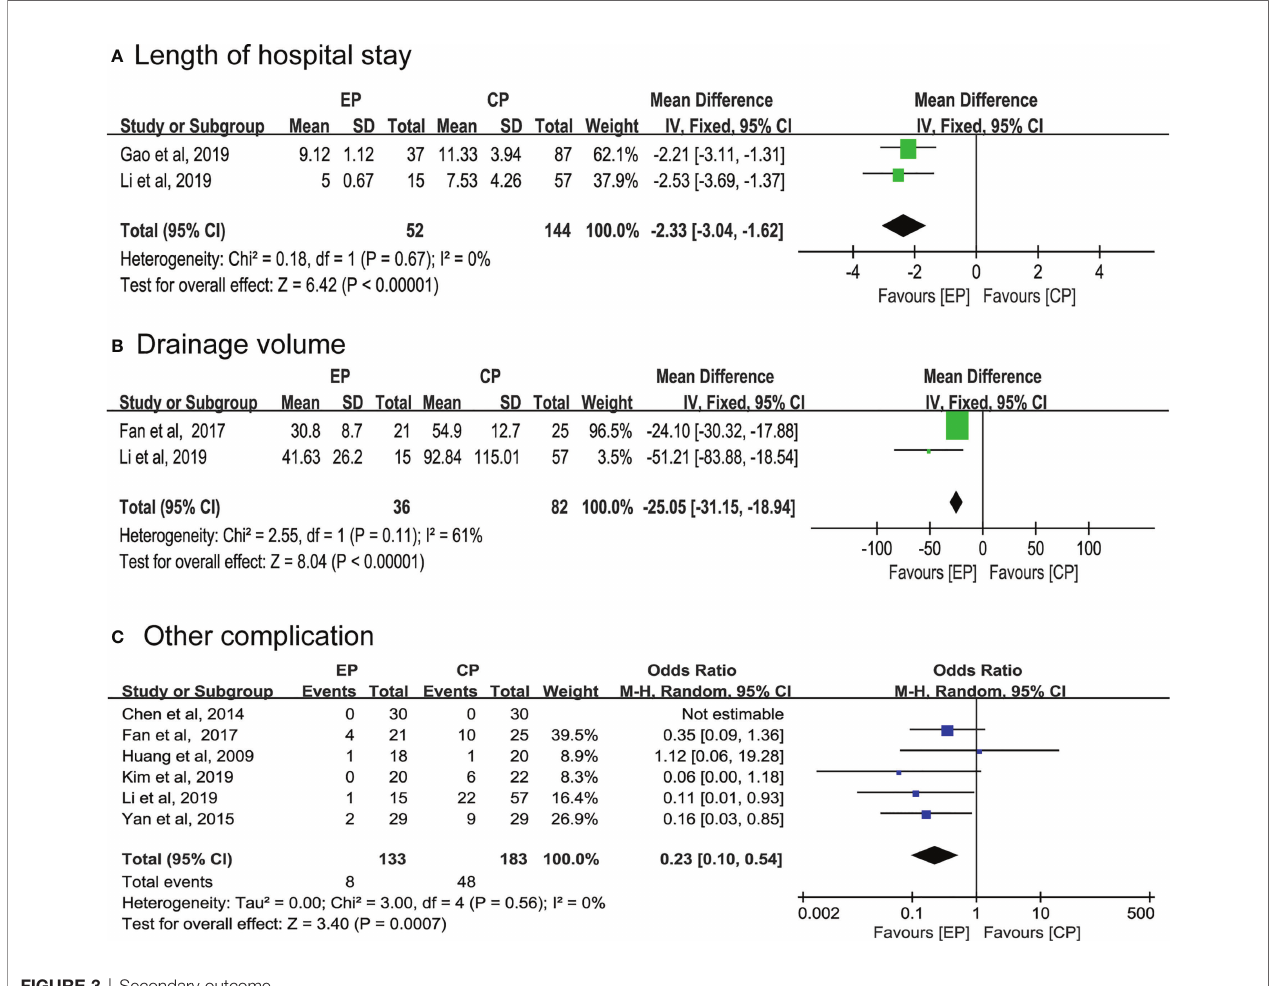
FIGURE 3 | Secondary